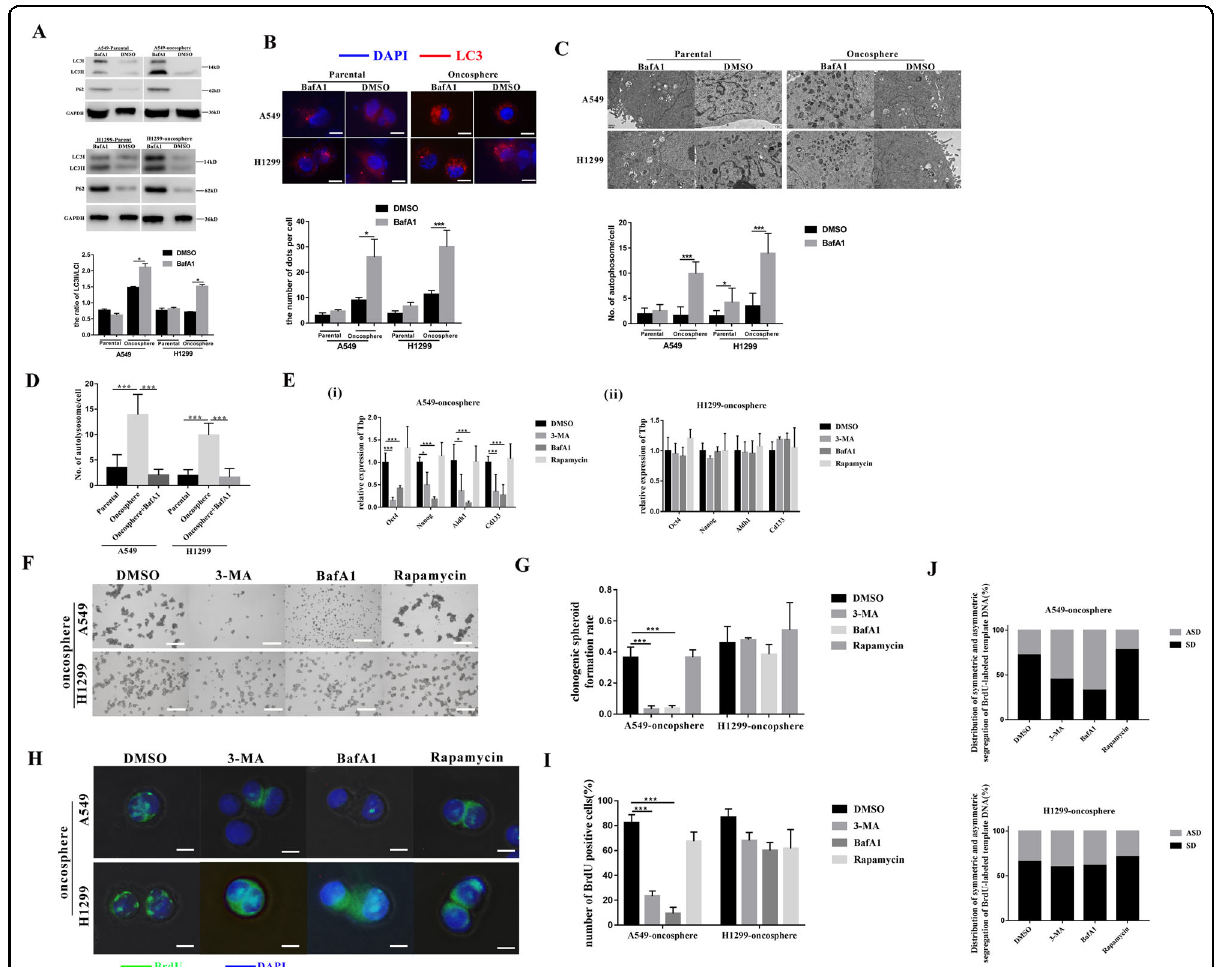
Fig. 2 Autophagy augments the stemness of A549-oncosphere in vitro. A Analysis of protein levels of LC3 and P62 in A549, A549 + BafA1, A549- oncosphere, A549-oncosphere + BafA1, H1299, H1299 + BafA1, H1299-oncosphere, and H1299-oncosphere + BafA1 by western blot (WB), GAPDH was used as a reference control. B Immuno fl uorescent staining of RFP-LC3 in A549, A549 + BafA1, A549-oncosphere, A549-oncosphere + BafA1, H1299, H1299 + BafA1, H1299-oncosphere, and H1299-oncosphere + BafA1; the red bar refers to LC3 and the blue bar refers to DAPI; white bar = 30 µm. C TEM analysis of autolysosomes in A549, A549 + BafA1, A549-oncosphere, A549-oncosphere + BafA1, H1299, H1299 + BafA1, H1299-oncosphere, and H1299-oncosphere + BafA1; bar = 1 µm. D Quanti fi cation of autolysosome in A549, A549-oncosphere, A549-oncosphere + BafA1, H1299, H1299- oncosphere, and H1299-oncosphere + BafA1. *** p < 0.01. E (i) and (ii) mRNA expression of Oct4, Nanog, Aldh1, and CD133 in A549-oncosphere and H1299-oncosphere treated with DMSO, 3-MA, BafA1, and rapa. Tbp was used as a reference control. * p < 0.05, *** p < 0.01. Colony formation assay ( F , bar = 120 µm) and single-cell cloning assay ( G , *** p < 0.01.) using A549-oncosphere and H1299-oncosphere treated with DMSO, 3-MA, BafA1, and rapa. H Image of BrdU immuno fl uorescence; the green bar refers to BrdU and the blue bar refers to DAPI ( H , white bar = 30 µm); and quanti fi cation of the number of BrdU-positive cells ( I , *** p < 0.01) in A549-oncosphere and H1299-oncosphere treated with DMSO, 3-MA, BafA1, and rapa. J Distribution of symmetric and asymmetric segregation of BrdU-labeled template DNA in A549-oncosphere and H1299-oncosphere treated with DMSO, 3-MA, BafA1, and rapa. The concentration of 3-MA, BafA1, and rapa was 3 mM, 100 nM, and 5 µM, respectively. Cells used in this fi gure were treated for 24